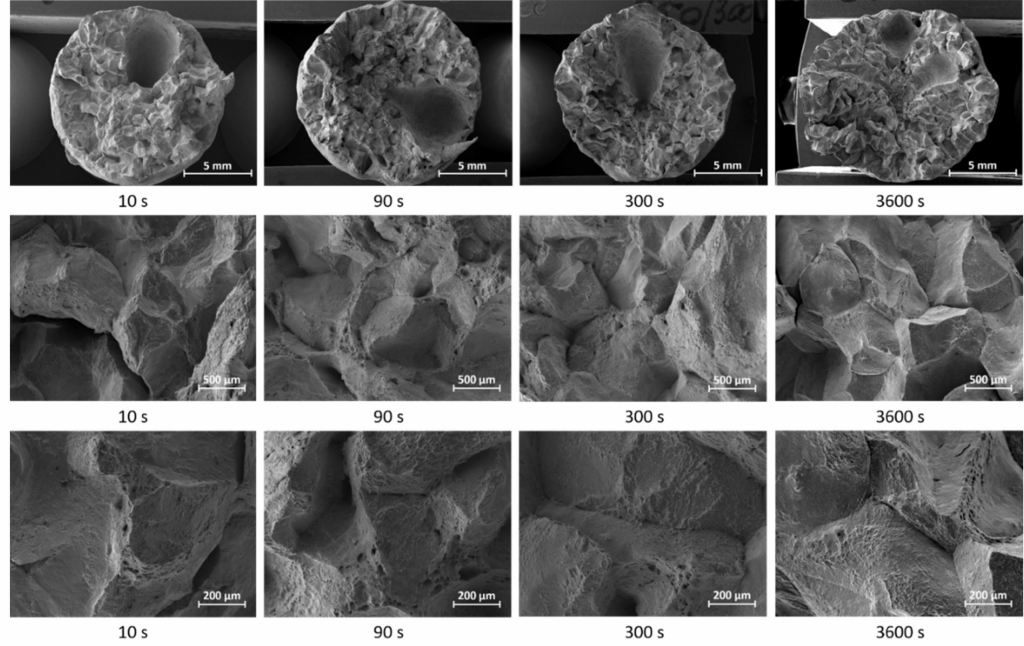
Figure 8. SEM images with 15 × , 100 × , and 250 × magnification for the samples tested at 850 ◦ C and different holding times.